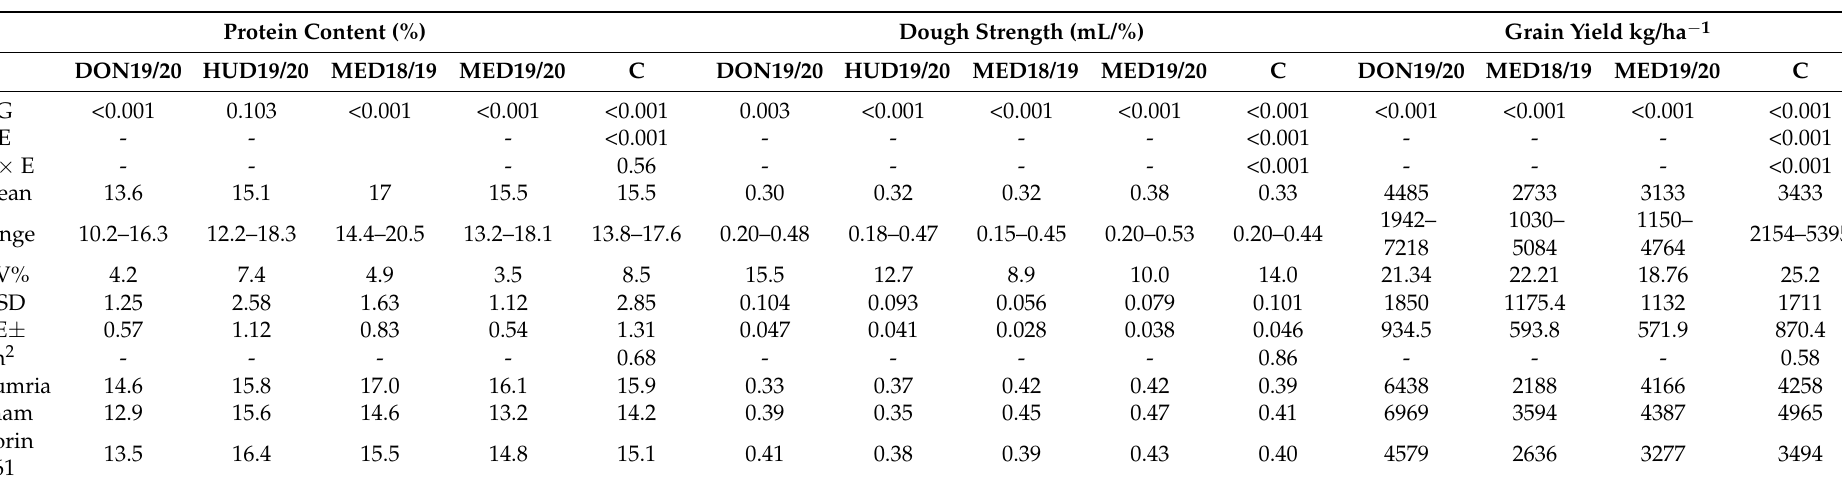
Table 1. Effects of genotype (G), environment (E), and their interaction on dough strength, protein content, and grain yield of multiple synthetic derivative